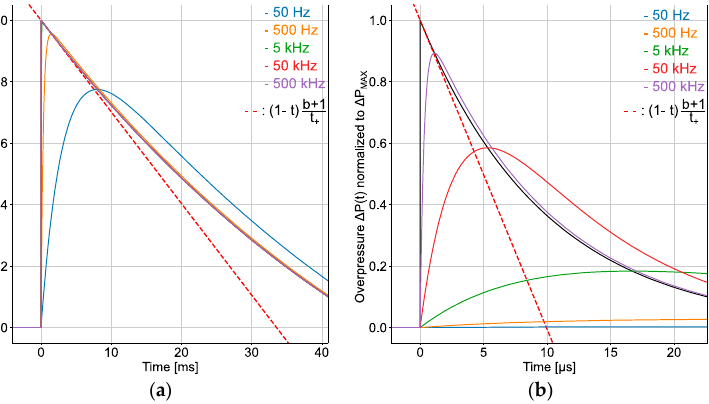
Figure 2. Friedlander waveform (in black) applied to the input of the first-order low-pass filter that models the frequency response of a pressure sensor for the side-on pressure measurement, and the waveform delivered at the output of the filter for various cut-off frequency f c (50 Hz in blue, 500 Hz in orange, 5 kHz in green, 50 kHz in red and 500 kHz in purple): ( a ) far-field and large-scale surface burst and side-on pressure measurement, and ( b ) small-scale and near-field surface burst and side-on pressure measurement. The ordinate is the ratio ∆ P ( t ) / ∆ P MAX